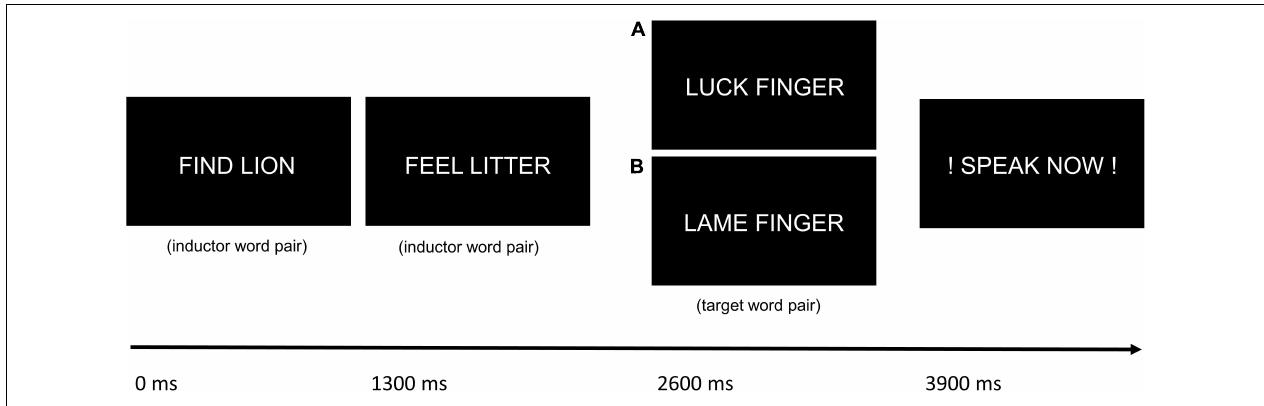
FIGURE 1 | Schematic drawing of the trial procedure with the taboo word spoonerism (A) and the neutral word spoonerism (B) eliciting condition. After the presentation of 1–4 inductor word pairs, a target word pair with inverse initials was presented, followed by the prompt to overtly articulate the word pair.